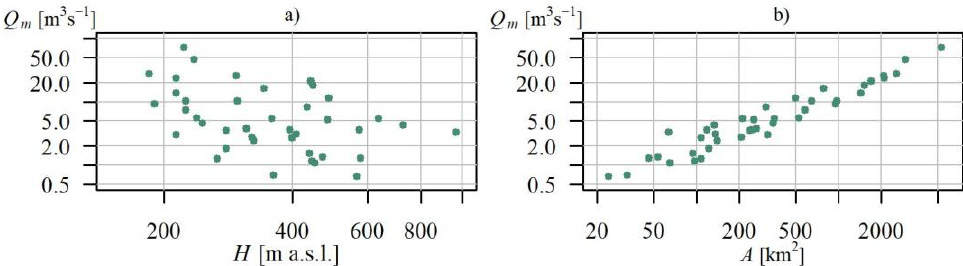
Figure 3. Scattergraph of relationship between average flow Q m and: ( a ) catchment area A ; and ( b ) gauging station elevation H , in Polish Carpathian, in the logarithmic (log-log) scales.